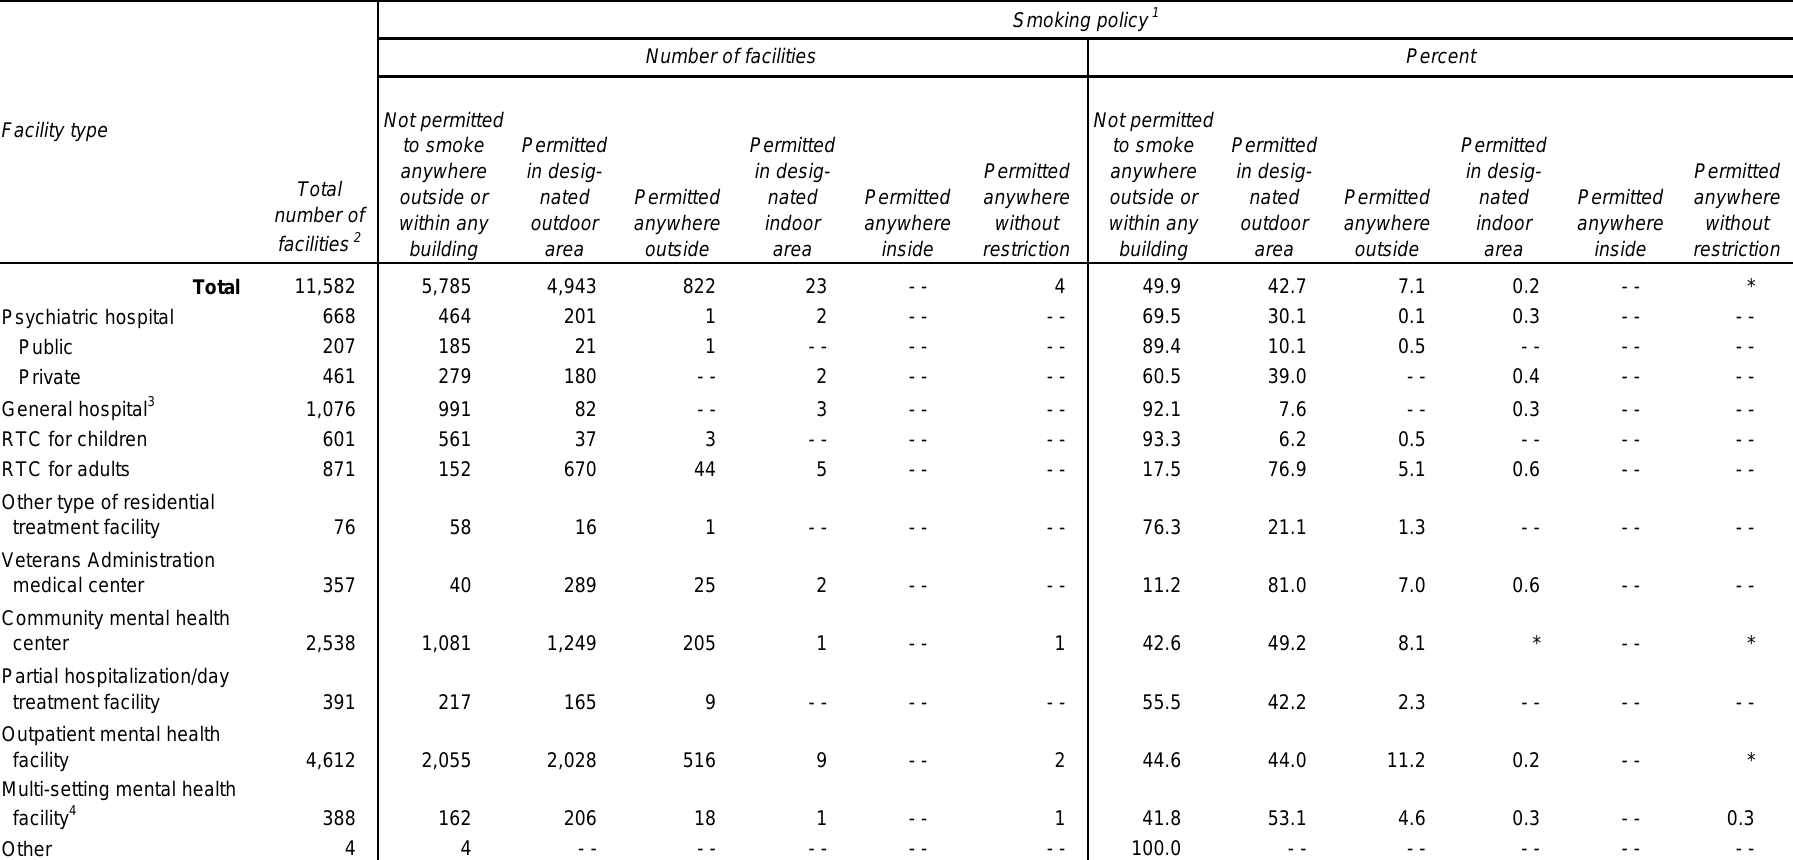
Table 2.10. Mental health treatment facility smoking policy, by facility type: Number and percent,